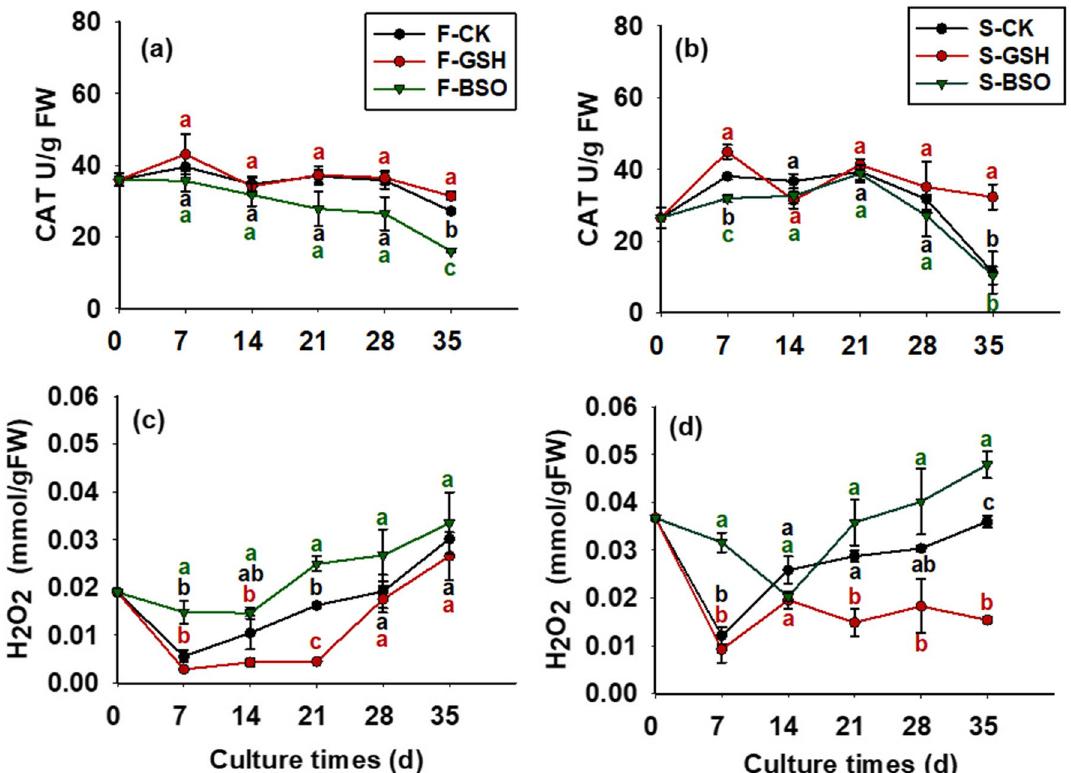
Figure 4. Effects of exogenous GSH and BSO on CAT and H 2 O 2 in two Korean pine cell